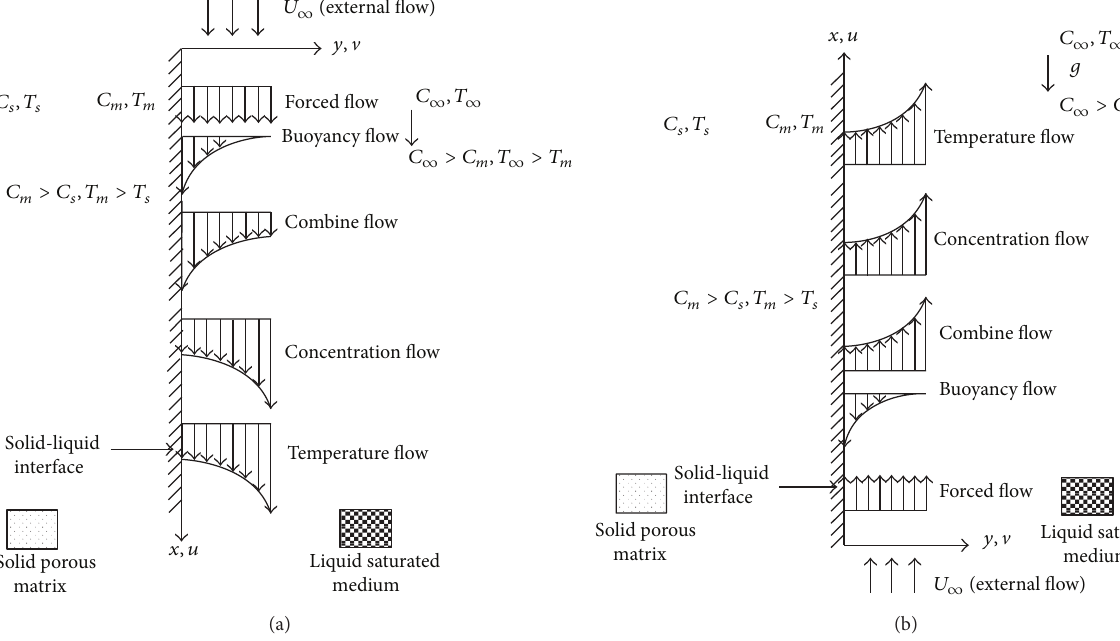
Figure 1: Physical model investigated in this study: (a) aiding external flow and (b) opposing external flow.